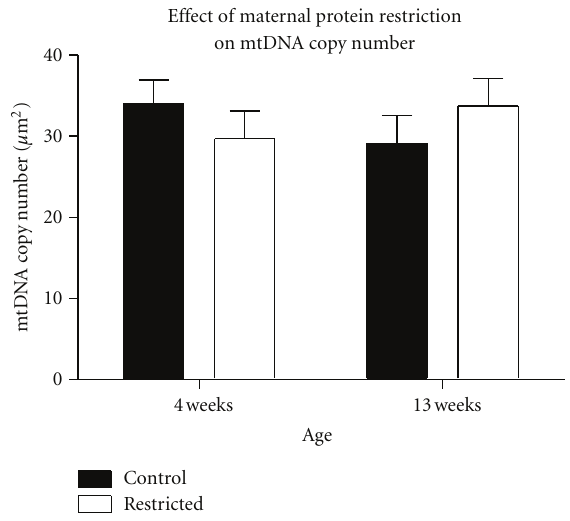
Figure 4: Mitochondrial DNA copy number in kidney as deter- mined by PCR. mtDNA copy number was una ff ected by maternal protein restriction. Values are means ± S.E.M. n =